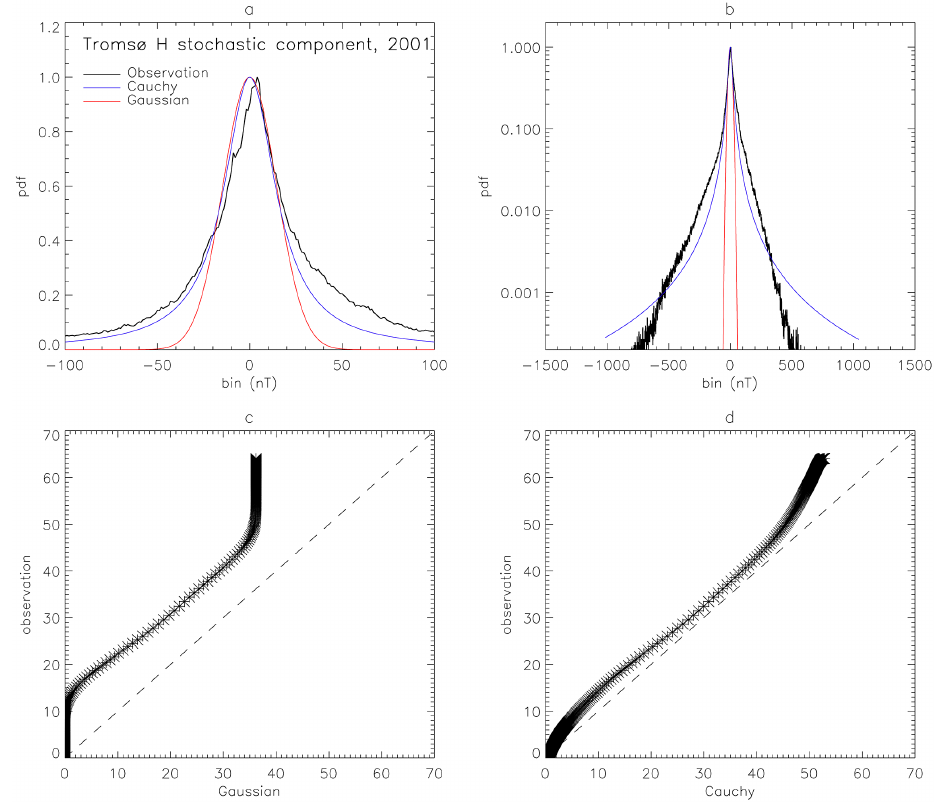
Figure 2. Portrayals of the distribution of the stochastic component of the H component of the geomagnetic field from 2001 as shown in Fig. 1. Top left: linear ordinate axis; top right: logarithmic ordinate axis. In the top panels Gaussian (red) and Cauchy (blue) distributions are fitted (explained and discussed in the text). Bottom left: Q–Q plot of the observed data versus Gaussian; bottom right: Q–Q plot of the observed data vs.